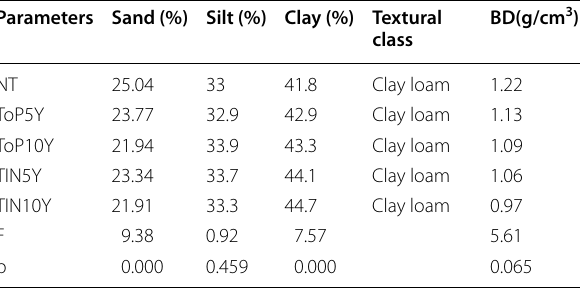
NT non-treated land, TolP5Y treated with only physical practices for 5 years, TolP10Y treated with only physical practices for 10 years, TIN10Y treated with integrate measures for 5 years, TIN10Y treated with integrate measures for 10 years